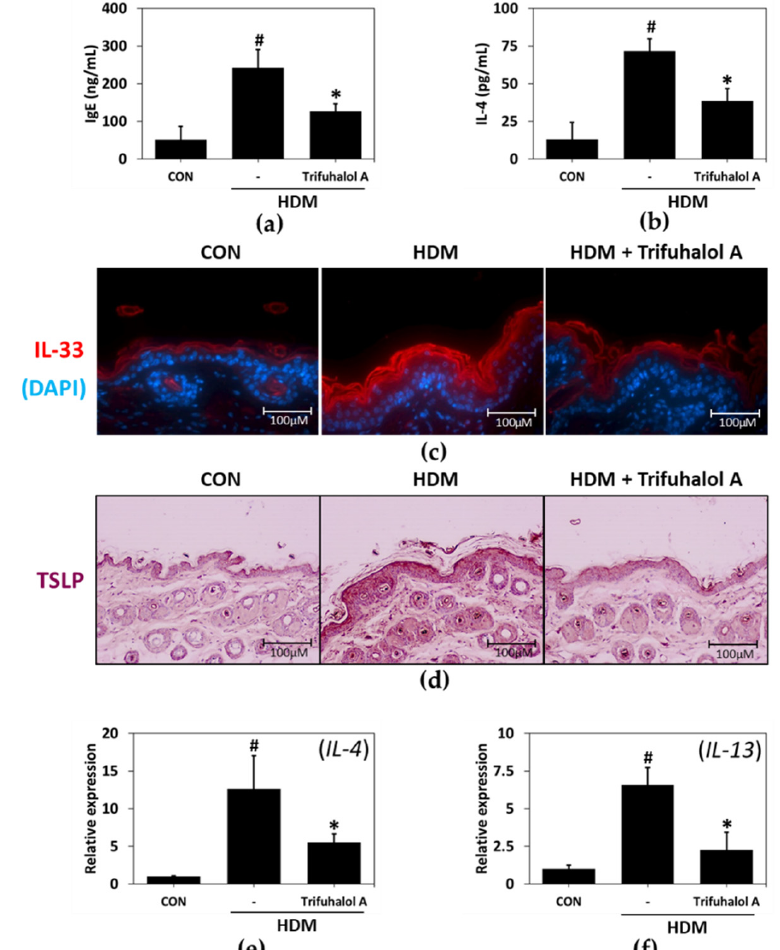
Figure 5. Effects of trifuhalol A on the serum and tissue factors related to allergic inflammation in HDM-induced AD-like NC/Nga mice. ( a ) Serum IgE and ( b ) IL-4 levels were measured using ELISA (n = 5 in each group). Immunohistochemistry was used to identify the expression level and sites of ( c ) IL-33 and ( d ) TSLP proteins in the skin (n = 5 in each group) (magnification × 100). Representative data of qPCR analysis of ( e ) IL-4 and ( f ) IL-13 mRNA normalized to GAPDH. Each bar represents the mean ± SE (n = 5 in each group). # p < 0.05 vs. control group; * p < 0.05 vs. HDM group.